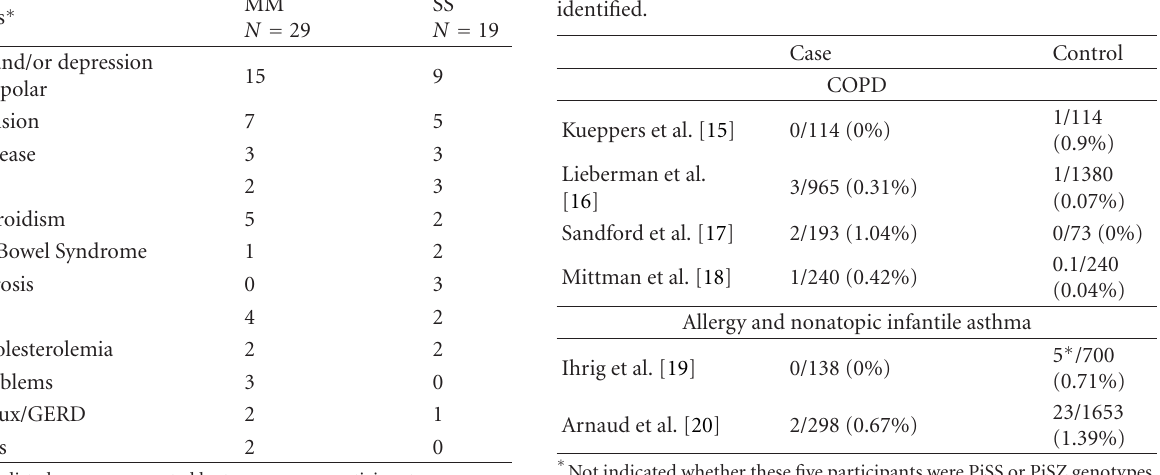
Table 4: Diagnoses with > 2 individuals reporting disease. Diagnosis ∗ Anxiety and/or depression and/or bipolar